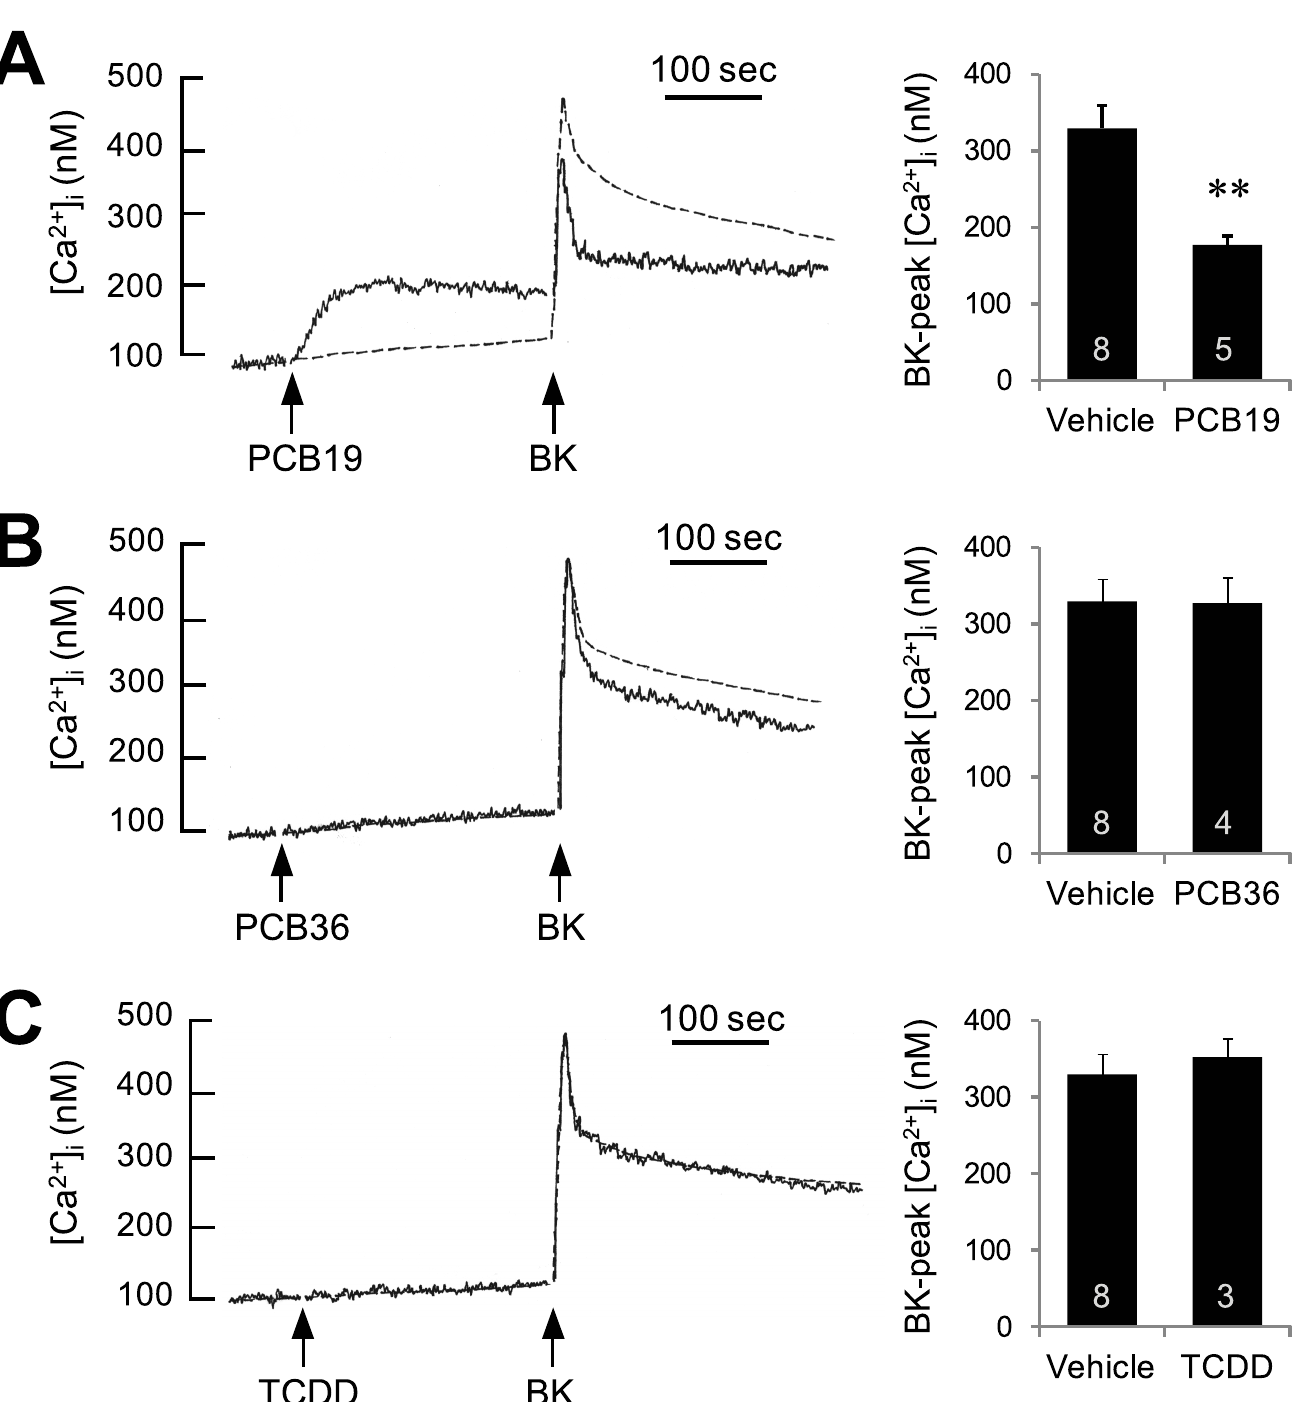
Fig 2. PCB19 inhibits bradykinin-induced increases of [Ca 2+ ] i in PC12 cells. (right) Fura-2-loaded PC12 cells were challenged with 50 μ M PCB19 ( A ), 50 μ M PCB36 ( B ), or 50 nM TCDD ( C ) and subsequently treated with 300 nM bradykinin. Responses to bradykinin alone, without PCB pretreatment, are also depicted (dotted traces). BK, bradykinin. (left) Peak changes in bradykinin-induced [Ca 2+ ]i increase were quantitatively analyzed. Number of experiments are depicted in bar graph and each point represents mean ± SEM. ** P < 0.01.